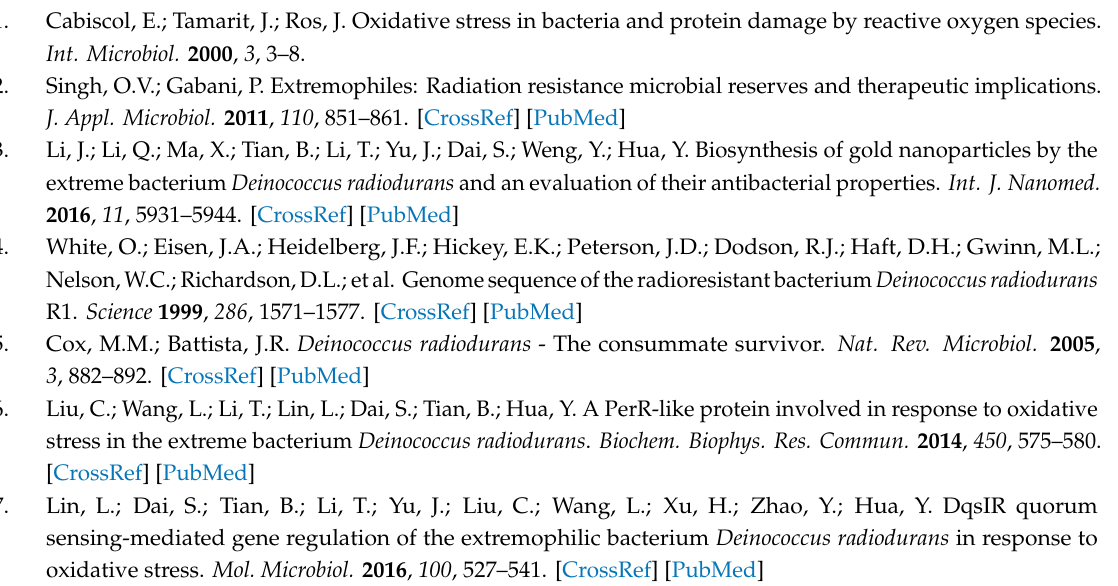
Table S1: Small RNA sequencing and classification in D. radiodurans R1, Table S2: Information of 24 sRNAs involved in oxidative stress response, Table S3: KEGG pathway analysis of oxidative response sRNAs in D. radiodurans R1, Figure S1: The sRNA length distribution in D. radiodurans R1 . The sRNA length (nt) is shown on the x-axis and the percentage of sRNA quantity is represented on the y-axis, Figure S2: qRT-PCR validation of 10 sRNAs identified by RNA-seq. Vertical values represent fold change (log 2 ) of small noncoding RNAs (sRNAs) at the transcriptional level after H 2 O 2 treatment, Figure S3: The deduced second structure of OsiA. The black line in the figure represents the common areas on OsiA where each target gene is combined. The color legends represent base pair